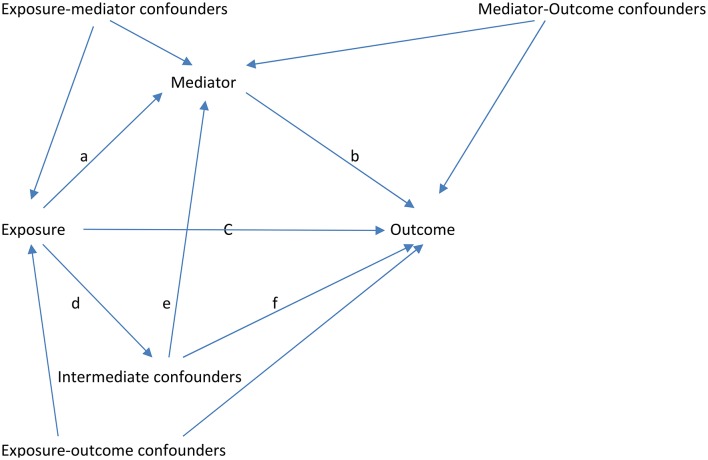
Causal diagram of the hypothesized effects of exposure, mediator, confounders, and intermediate confounders on outcome.